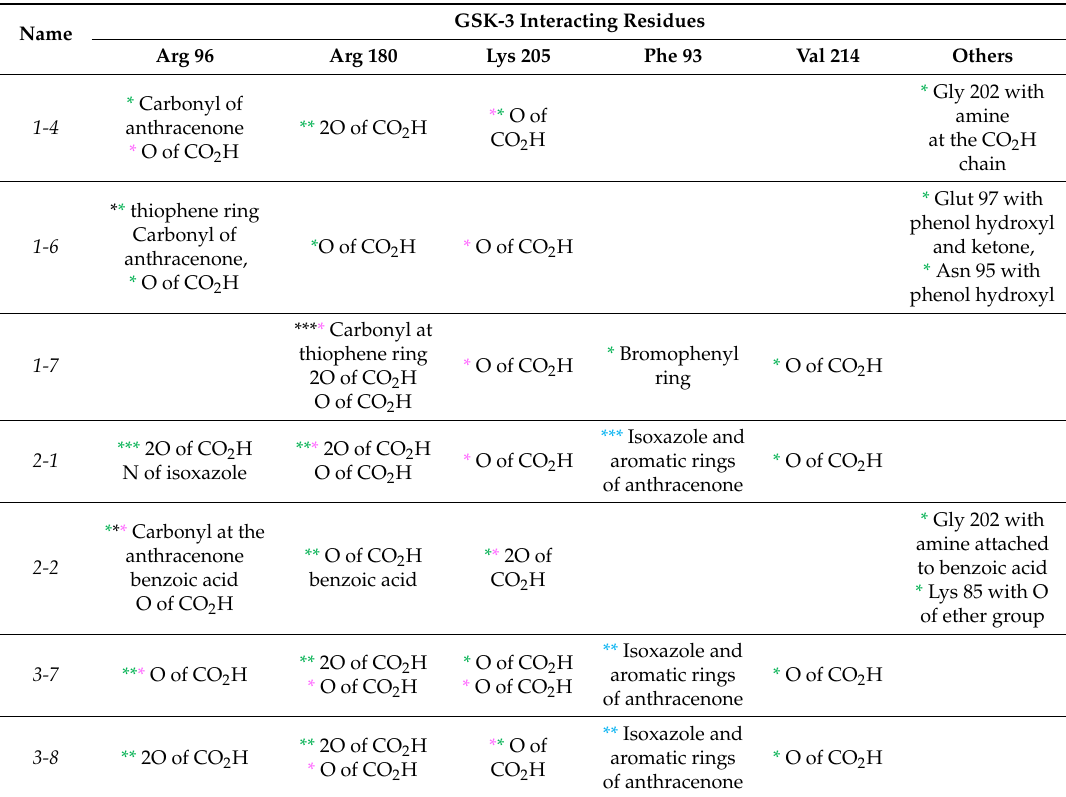
Table 1. GSK-3 interactions with selected compounds. The number of interactions (*), type of interaction, and atom / substructure involved are listed for each GSK-3 residue. Green, H-bond, blue πι – π stacking, black, cation– π , pink, salt